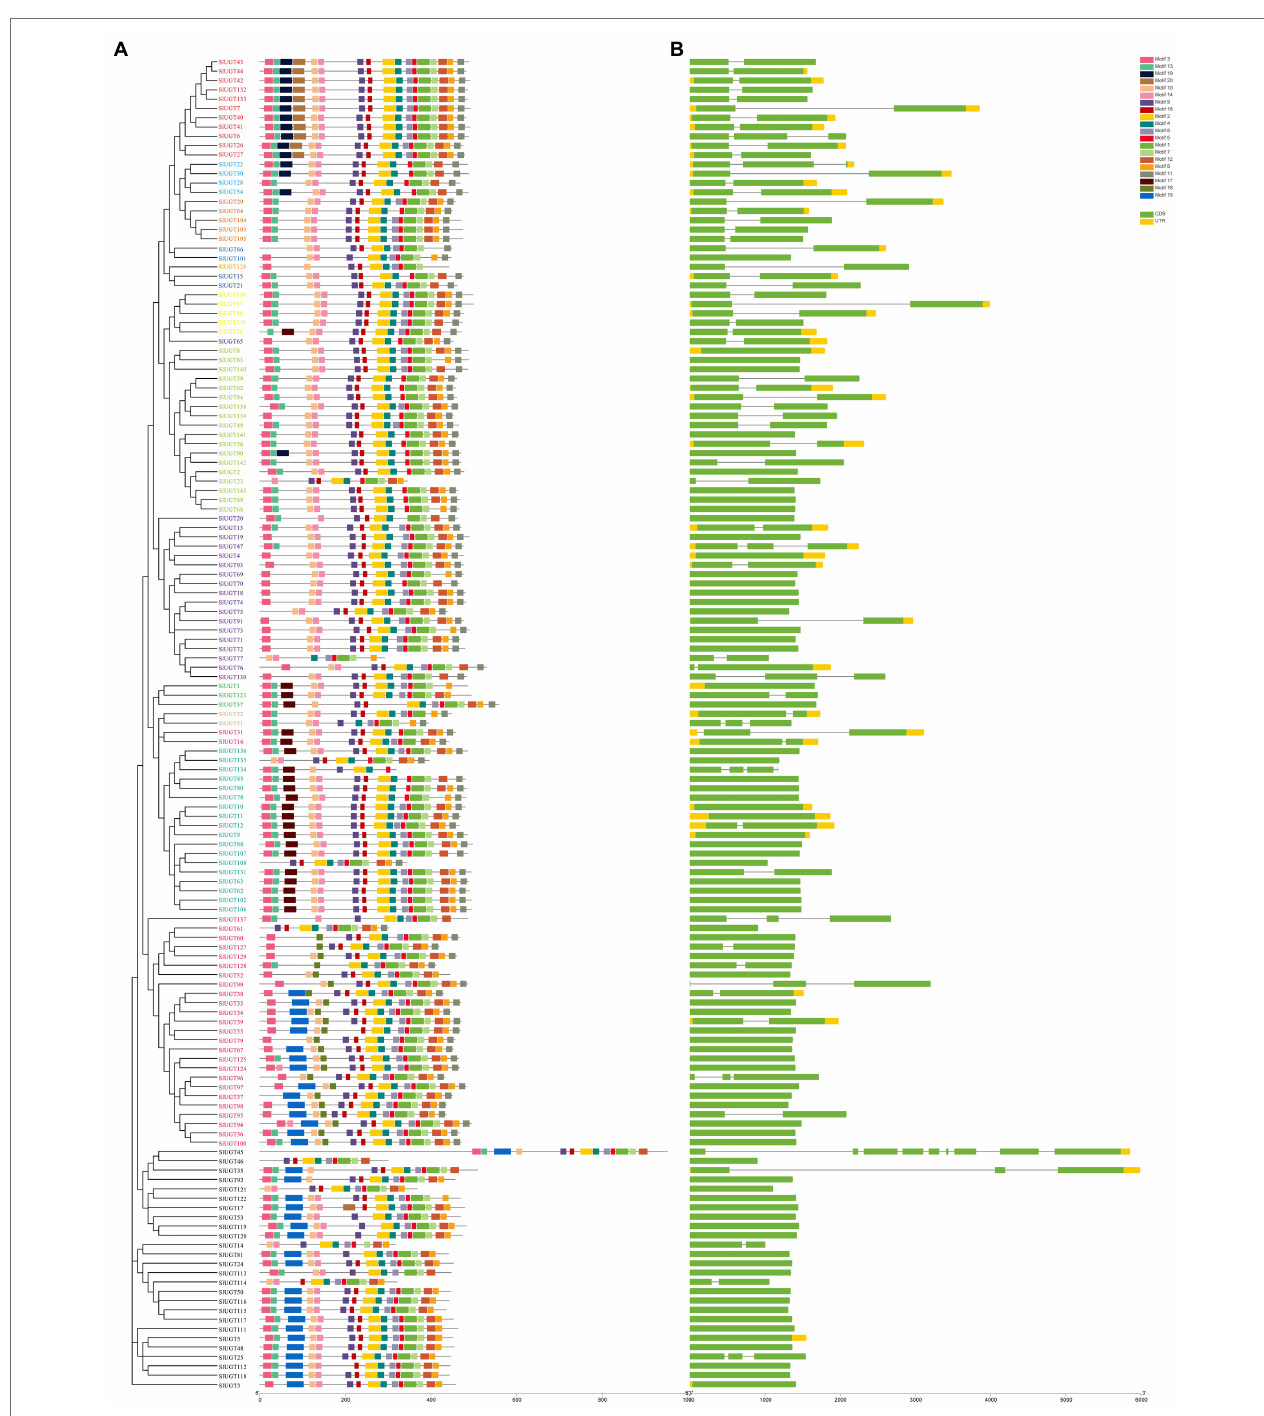
FIGURE 8 | Gene structure and architecture of conserved motifs in SlUGT genes. (A) The motif composition of SlUGT proteins. Different colors represented different motifs. (B) Exon-intron structure and conserved domain of SlUGT